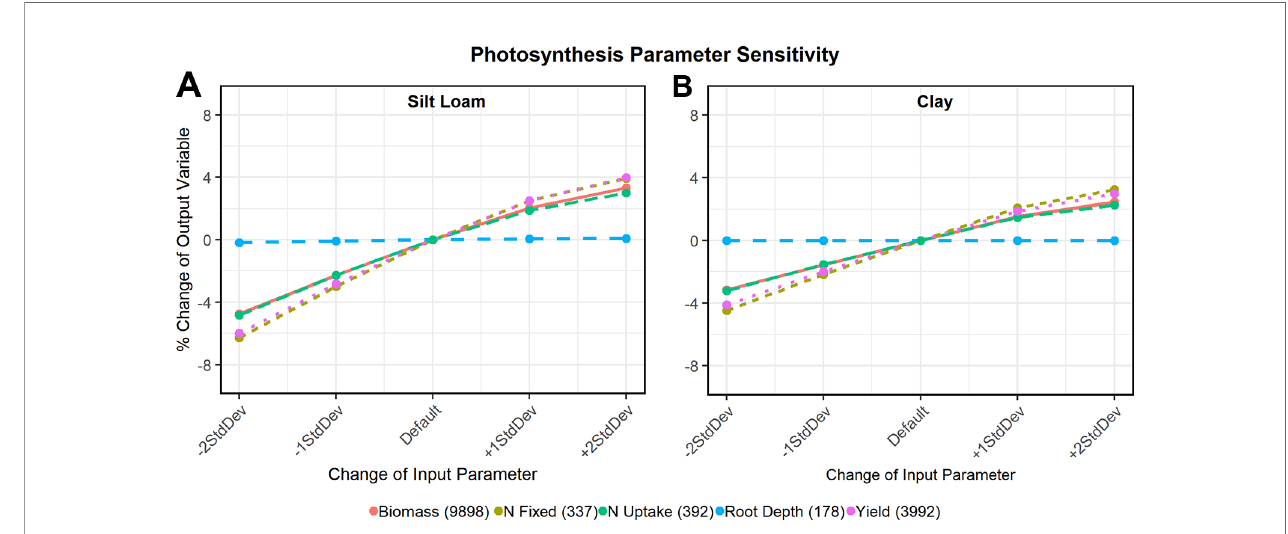
FIGURE 6 | Sensitivity analysis of oxdef_photo parameters on a silt loam soil (A) and clay soil (B) . The output variables (y-axis) shown in each graph are biomass (kg ha-1), N uptake (kg ha-1), N fi xation (kg ha-1), maximum root depth (cm), and end of season grain yield (kg ha-1). In the legends, the numbers in parentheses in the output variables refer to the default